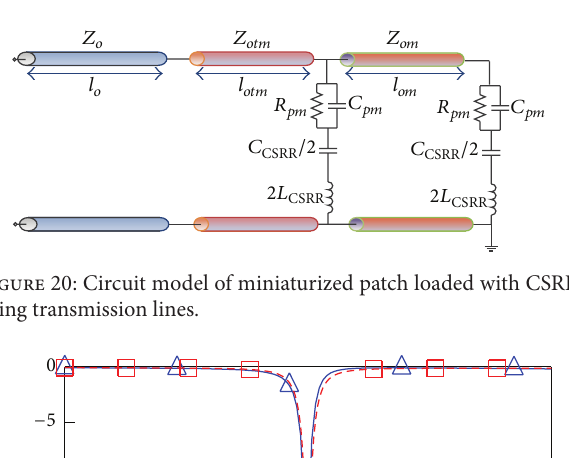
Figure 19: Comparison of circuit model and simulated phase of reflection coefficient results of traditional patch antenna.